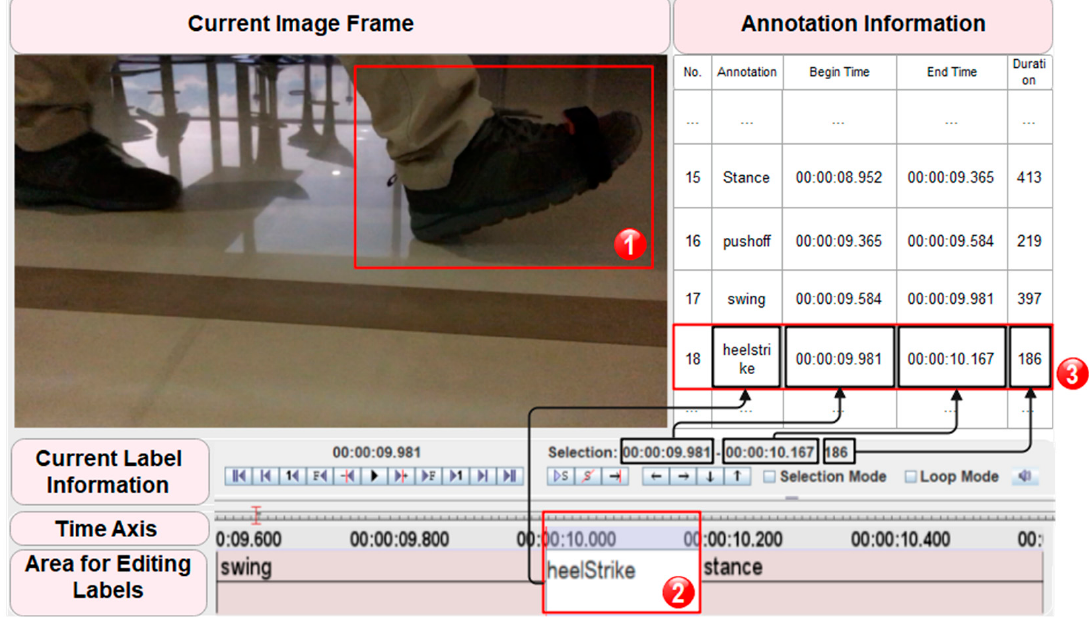
Figure 4. In the ELAN interface, the Current Image Frame shows the target’s movement state at the moment; the Current Label Information shows the time range corresponding to the series of images selected by the user. When a specific movement state is captured (box 1), the user stops opening the next frame and edits the label for the corresponding gait in the Area for Editing Labels (box 2); Annotation Information records the detailed information that has been labeled so far, and the latest label item is located in the bottom of label history (box